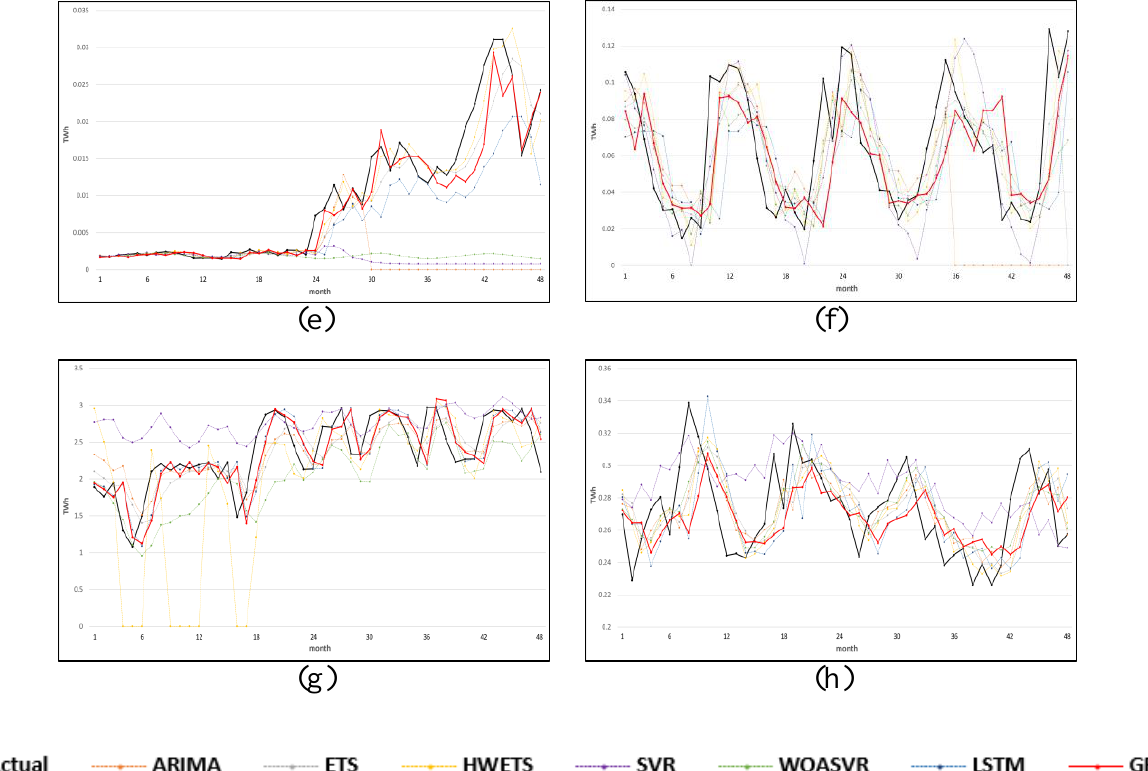
Figure 5. Predictions obtained using the seven models for ( a ) the generation of coal power, ( b ) liq- uefied natural gas (LNG) power, ( c ) oil power, ( d ) conventional hydropower, ( e ) solar photovoltaic power, ( f ) wind power, ( g ) nuclear power, and ( h ) pumped hydropower.